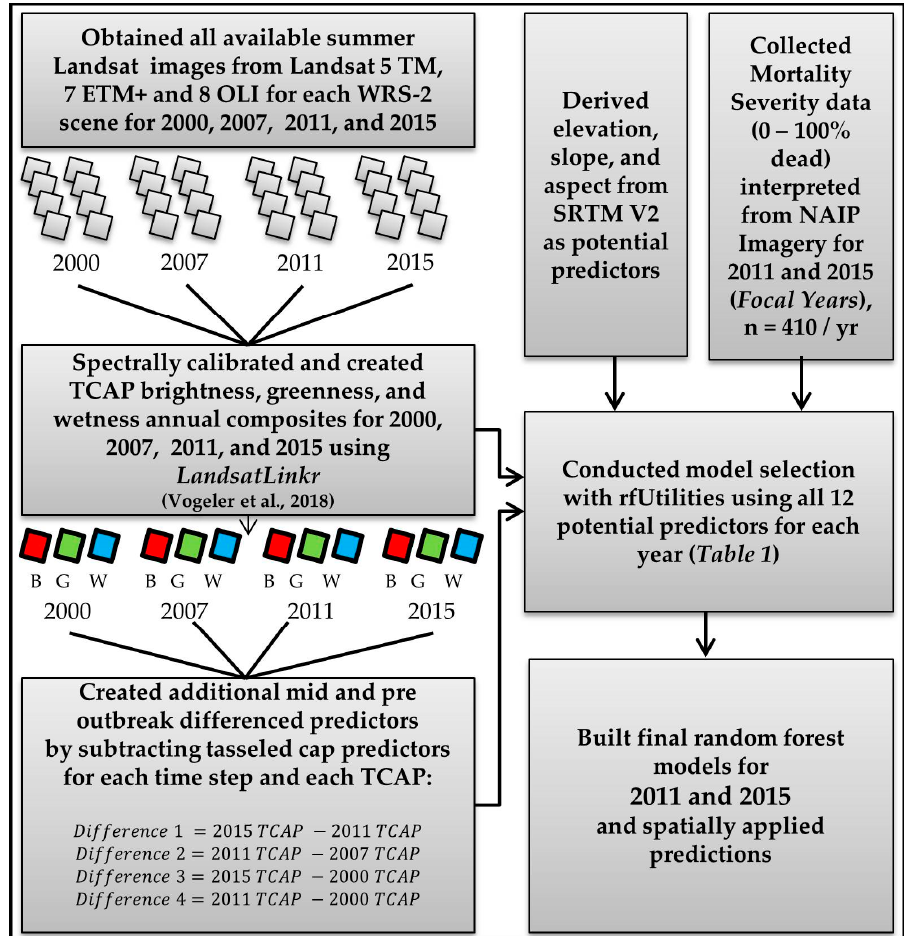
Figure 2. A generalized workflow for our final maps of spruce beetle induced mortality in 2011 and 2015.TM: Thematic Mapper; ETM: Enhanced Thematic Mapper; OLI: Operational Land Imager; WRS-2: Worldwide Reference System 2; SRTM V2: Shuttle Radar Topography Mission Version 2; NAIP: National Aerial Imagery Program; TCAP: Tasseled cap Table 1. A summary of all predictive layers produced for each year (2011 and 2015) using Landsat-derived tasseled cap transformations. Each predictor was considered in the final RF predictive models of % canopy mortality.